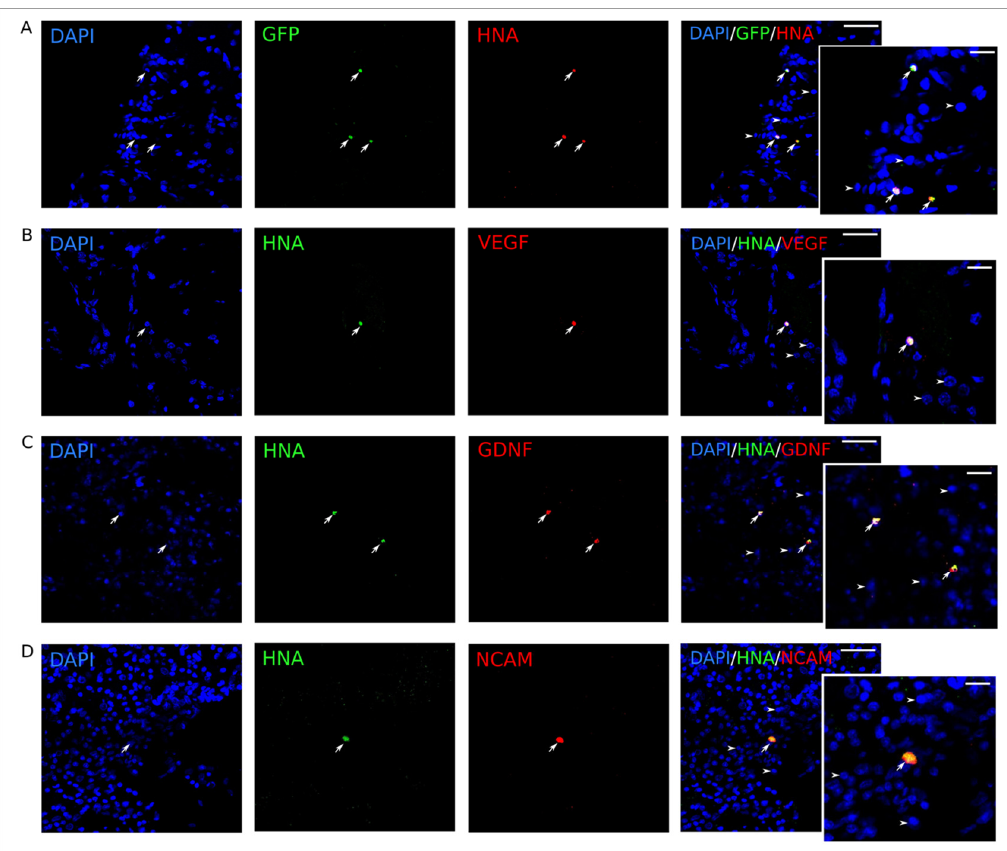
Figure 11. Expression of recombinant molecules in rat brain on the 24th day after intrathecal injection of UCB-MC+Ad5-GFP and UCB-MC+Ad-VEGF-GDNF-NCAM. UCB-MC+Ad-VEGF-GDNF-NCAM are visualized with antibody against the human nuclear antigen (HNA). Cell nuclei are counterstained with DAPI (blue glow). ( A )—Specific green glow in UCB-MC+Ad5-GFP. ( B )—Immune reaction with antibody against vascular endothelial growth factor (VEGF) (red glow). ( C )—Immune response with antibody against glial-derived neurotrophic factor (GDNF) (red glow). ( D )—Immune response with antibody against neuronal cell adhesion molecule (NCAM) (red glow). Arrows point to the UCB-MC. Arrowheads indicate cell nuclei visualized using DAPI (blue glow). Scale bar in ( A – D ) = 50 µm; scale bar in the inserts = 20 µm.